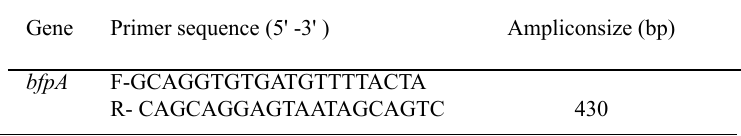
table 2. List of various bacterial strains employed to determine specificity of IgY by dot-ELISA Bacterial strain